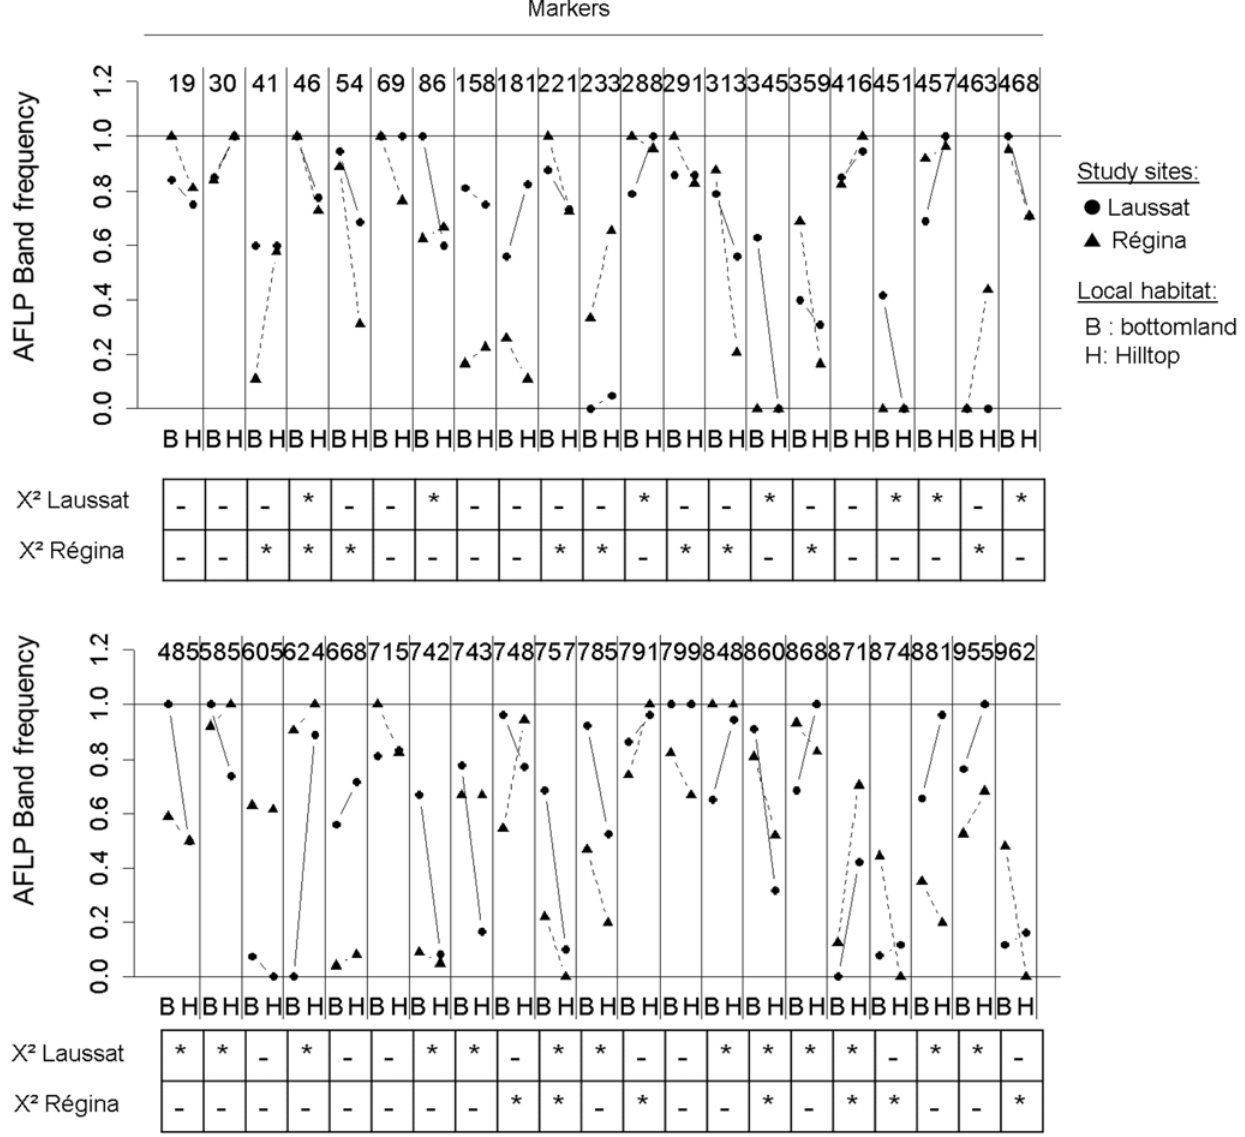
Fig 8. Band presence frequency (allele ‘ 1 ’ ) in each local habitats ( ‘ B ’ : bottomland, ‘ H ’ : hilltop) and each study site (circles: Laussat, squares: Régina). The tables below show the result of X² tests on AFLP band frequency (' * ': significant; ‘ - ’ : non-significant or missing).